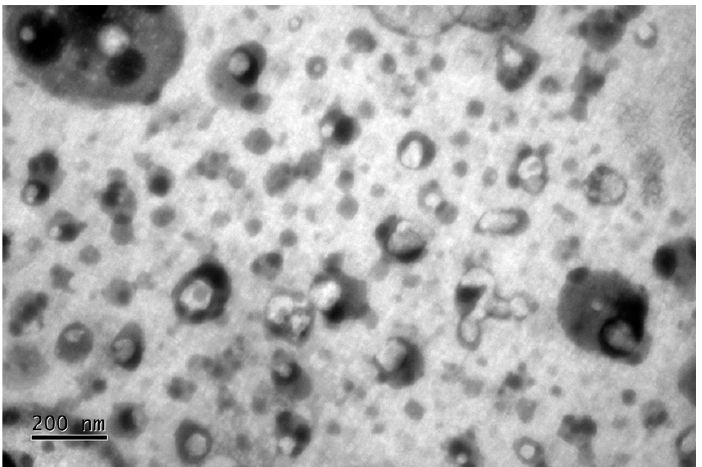
Figure 5. Image obtained by TEM of microemulsion with EXT corresponding to 0.05% GA incorpo-